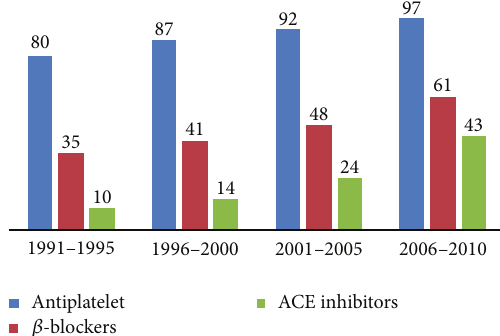
Figure 1: Trends in hospital medications (%) over 2 decades.